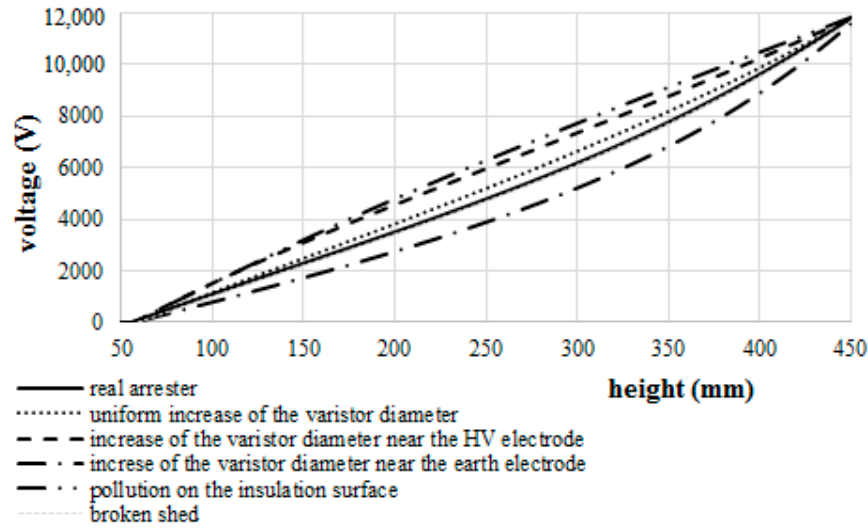
Figure 18. Comparison of the voltage distribution along the non linear resistance for the examined cases of sections 4 and